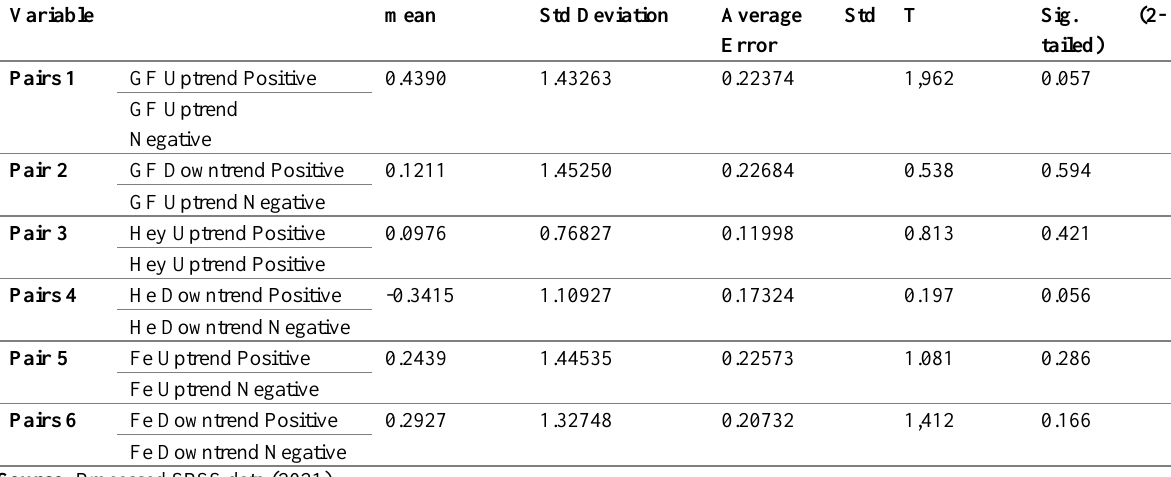
Table 2: Paired T Test between Positive and Negative Statements When Conditions are Uptrend and